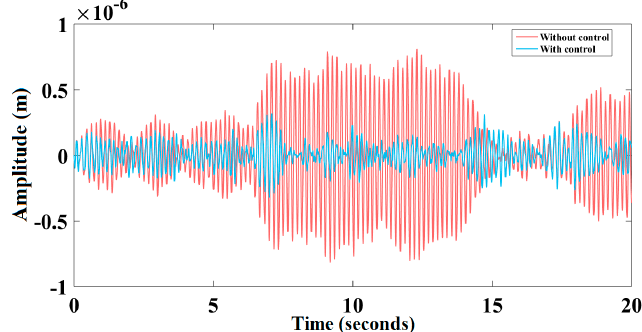
Figure 6. White noise response (Sensors in FE1, Q = 10 13 , R = 1, Gc = 100).